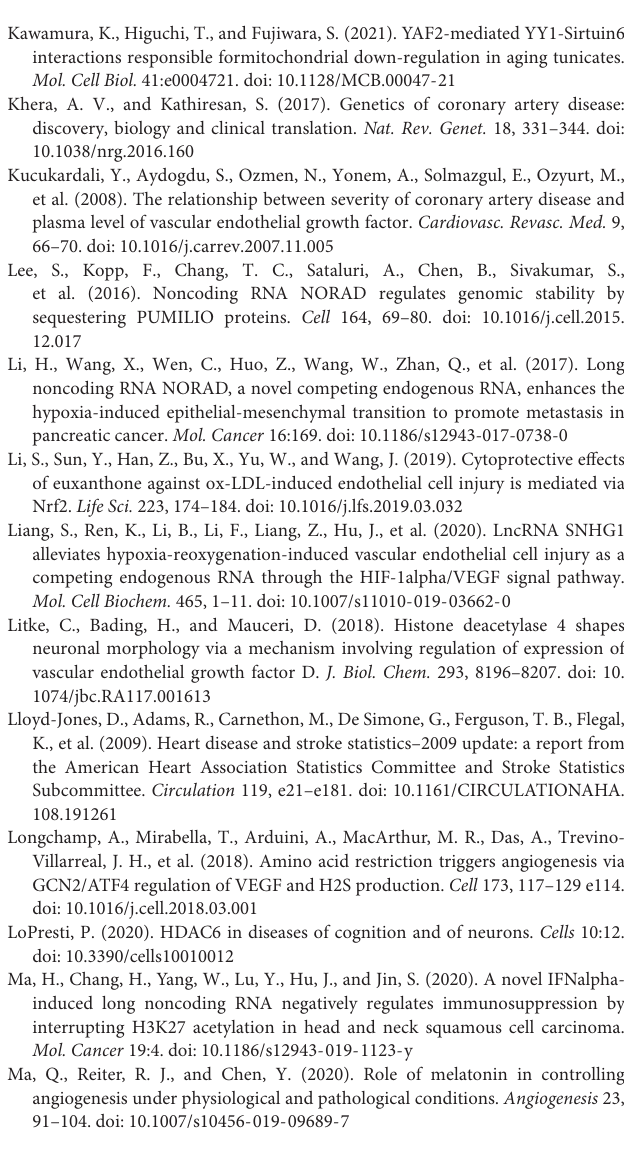
Supplementary Figure 1 | Representative images of silver staining for RAP assays. (A–C) Representative images of silver staining for RAP assays performed in ox-LDL-treated HUVECs (A) , HUVECs transfected with control shRNA (B) , or HUVECs transfected with shRNA-targeting lncRNA NORAD (C) . NC, negative control. Supplementary Figure 2 | Representative images of silver staining for Co-IP performed in nucleus of ox-LDL-treated HUVECs. Ab, antibody. Supplementary Figure 3 | The mRNA level of FUS in HUVECs transfected with control siRNA or FUS siRNA. siCtrl, control siRNA; siFUS, FUS siRNA. N = 3. ∗∗∗∗ P < 0.0001 vs. siCtrl